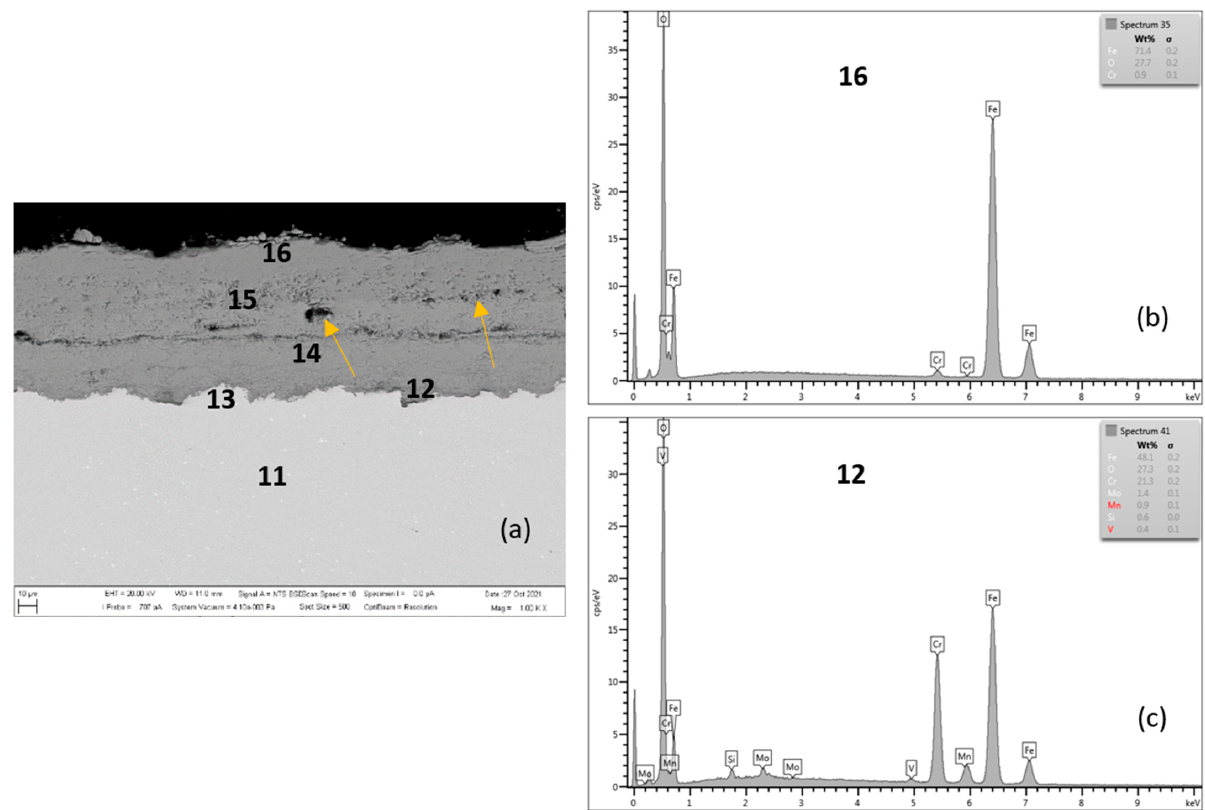
Figure 8. Steel P91 after 2000 h at 650 °C ( a ), EDX analysis from location 16 ( b ) (outer oxide layer) and location 12 ( c ) (interface substrate/oxide layer).